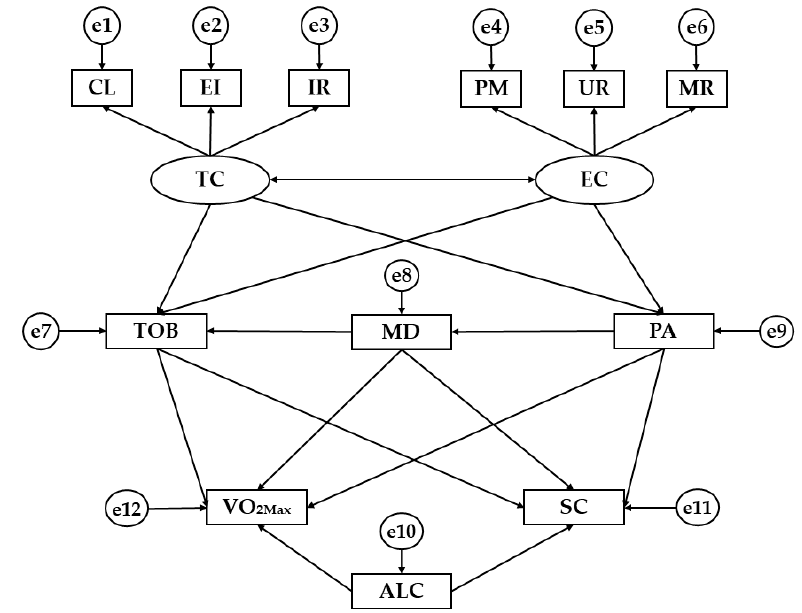
Figure 1. Structural Equation Model. Note: TC, Task Climate; EC, Ego Climate; CL, Cooperative Learning; EI, Effort/Improvement; IR, Important Role; PM, Punishment for Mistakes; UR, Unequal Recognition; MR, Member Rivalry; TOB, Tobacco; MD, Mediterranean Diet; PA, Physical Activity; ALC, Alcohol; VO 2MAX , Maximum oxygen consumption (mL/min/kg); SC; Self-concept.